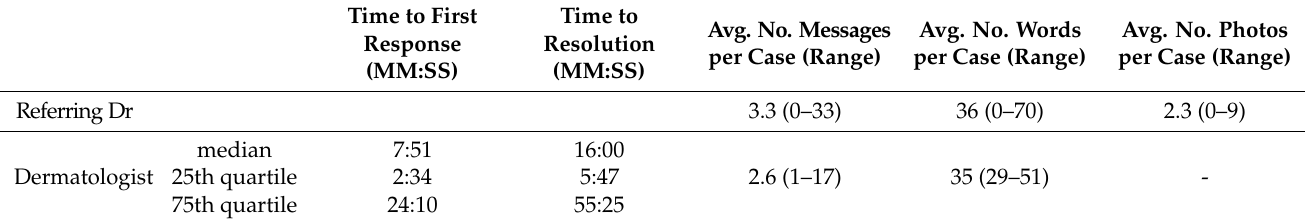
Table 2. Summary of the content and response times of 322 cases with 1864 WhatsApp messages. (‘Case’ refers to all messages and photographs per completed